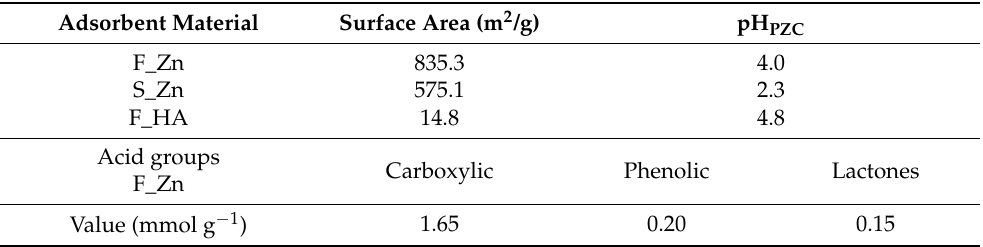
Table 1. Physical and chemical surface properties. PZC, point of zero charge.